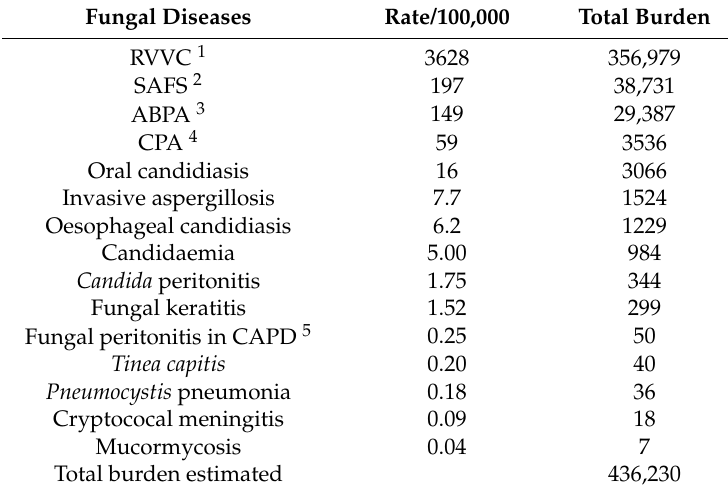
Table 1. Serious fungal diseases in